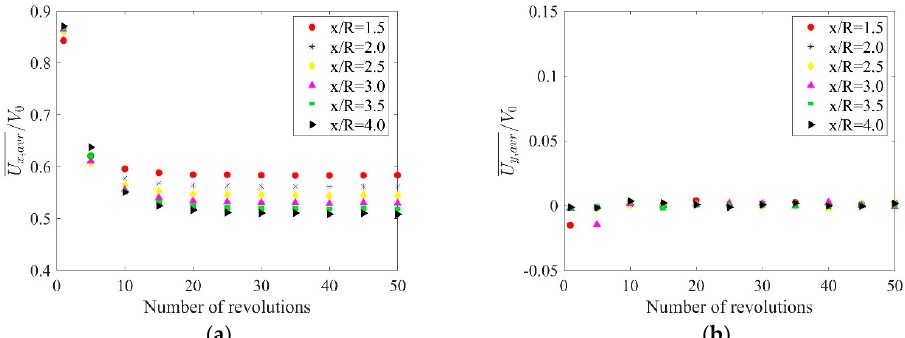
Figure 15. Averaged velocity profiles for different positions downstream behind the rotor for ( a ) U x velocity component; ( b ) U y velocity component.